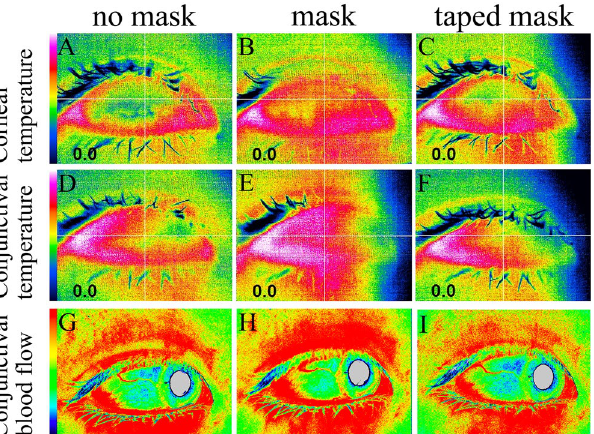
Figure 3. Representative images of corneal and conjunctival temperature ( A to F ) and conjunctival blood flow ( G to I ). Corneal temperature with no mask (33.85 ℃ , A ), mask (34.31 ℃ , B ) and taped mask (34.08 ℃ , C ). Conjunctival temperature with no mask (34.08 ℃ , D ), mask (34.47 ℃ , E ) and taped mask (34.19 ℃ , F ). Conjunctival blood flow with no mask (191.3, G ), mask (256.5, H ) and taped mask (178.4, I ). Images were made using Adobe photoshop elements 2018